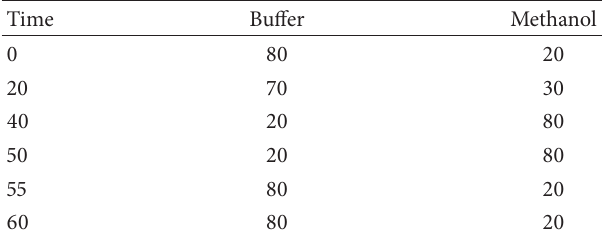
Table 2: Gradient program.